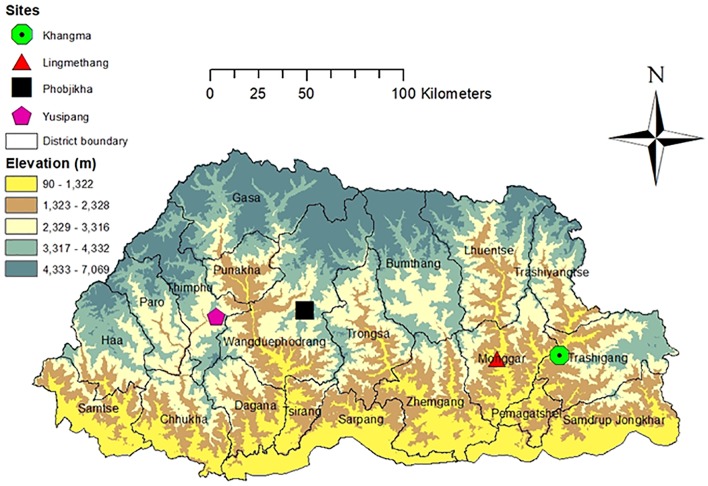
Elevation map of Bhutan with the location of the two study sites.Elaborated by the 1st author TK at Ministry of Agriculture, Bhutan.